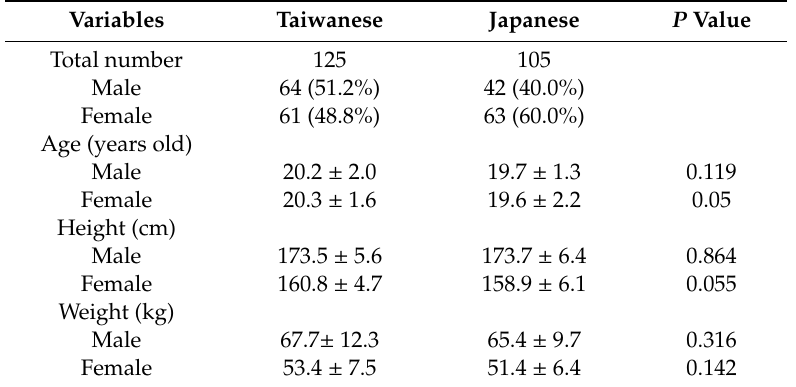
Table 1. Demographic characteristics of the respondents (Taiwanese and Japanese students).